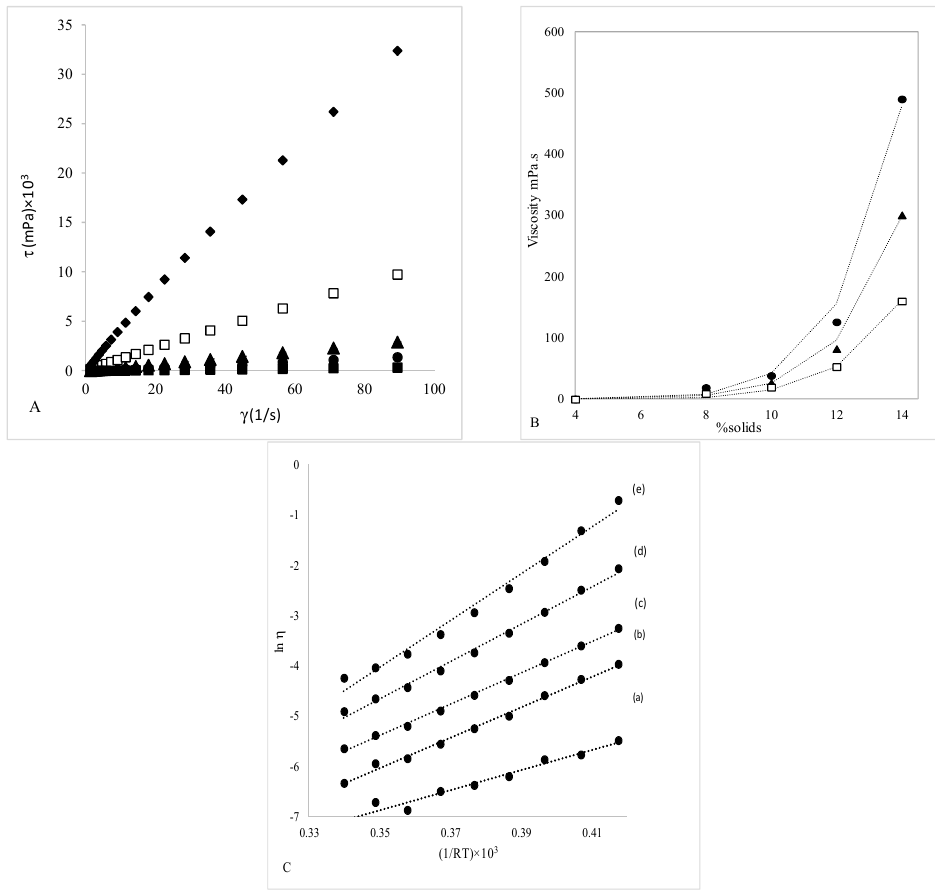
Figure 1. Shear stress versus shear rate of the SC solutions at different concentrations: 4% ( ■ ), 8% ( ● ), 10% ( ▲ ), 12% ( □ ), and 14% ( ♦ ) ( A ). Effect of solid concentrations on viscosity at three temperatures: 15 °C ( ● ), 22.5 °C ( ▲ ), and 30 °C ( □ ). Dot lines represent the predicted value from Equation (2) ( B ). Effect of temperature (Arrhenius plot) on the viscosity of SC solutions at concentrations of (a) 4%, (b) 8%, (c) 10%, (d) 12%, and (e) 14% ( C ).